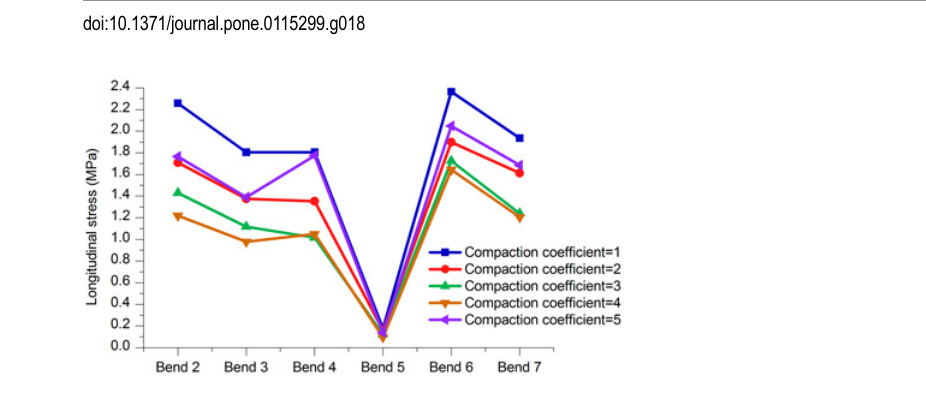
Fig 19. Longitudinal displacement of bends with different Compaction